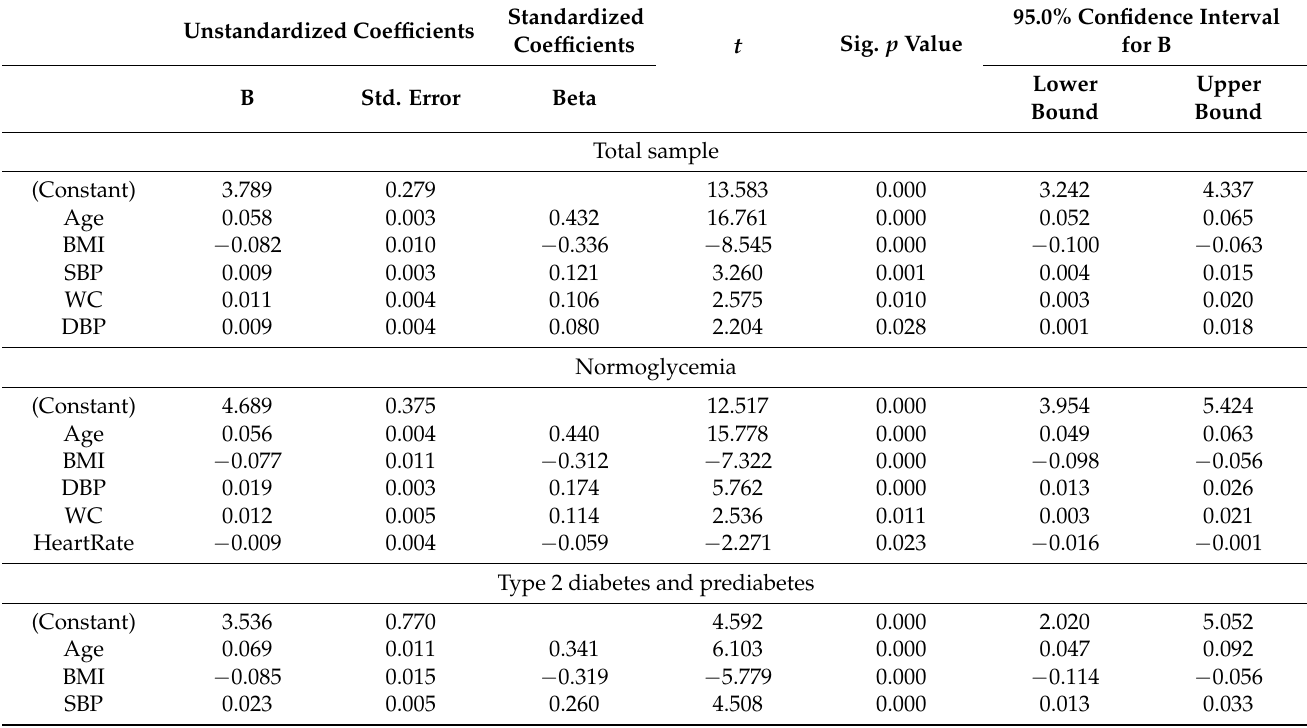
Table 2. Linear regression analysis (stepwise method) for the relationship of CAVI with other continuous variables ( n = 1491).